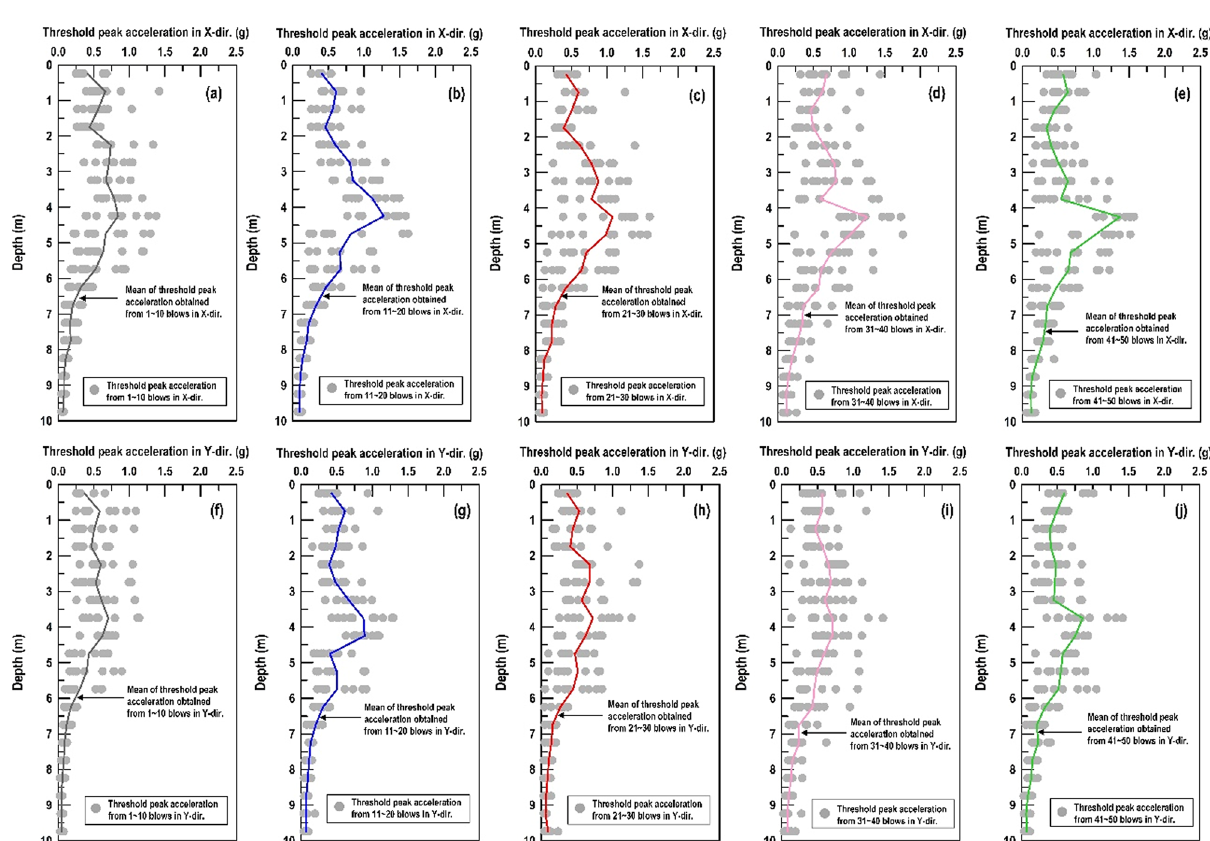
Figure 10. Distributions of the threshold peak acceleration and mean obtained from the vertically installed SAA string during RIC compaction at impact points 1–8: ( a – e ) X-direction response during 1–10, 11–20, 21–30, 31–40, and 41–50 blows; ( f – j ) Y-direction response during 1–10, 11–20, 21–30, 31–40, and 41–50